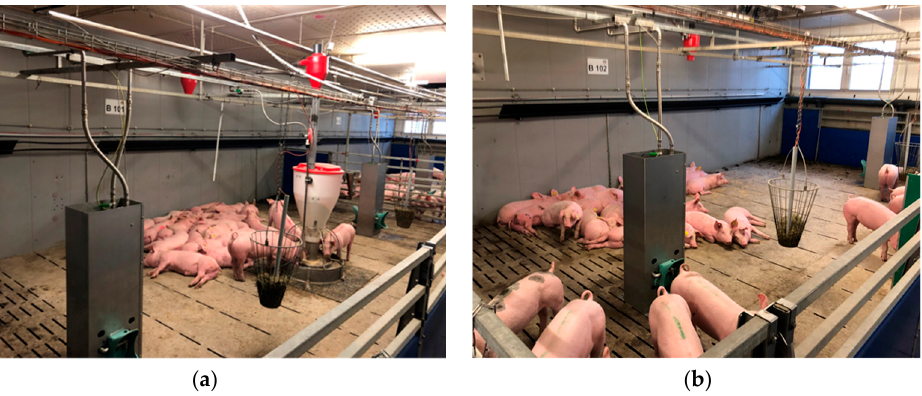
Figure 2. Photos of pen of ( a ) design A and ( b ) design B.